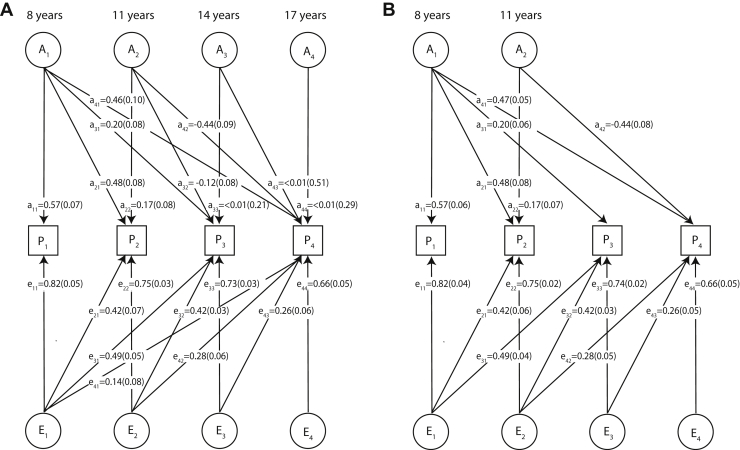
Path diagram of the full Cholesky decomposition model for Social and Communication Disorders Checklist scores (A) and its reduced form (B). The full Cholesky decomposition model (A) and its most parsimonious reduced form (B) are described in detail in Table 1 (model 1 and 5, respectively). Corresponding to the phenotypic measures P1 (8 years), P2 (11 years), P3 (14 years), and P4 (17 years), the latent genetic factors with factor loadings (a) are A1 (8 years), A2 (11 years), A3 (14 years), and A4 (17 years), and the latent residual factors with factor loadings (e) are E1 (8 years), E2 (11 years), E3 (14 years), and E4 (17 years). All path coefficients are standardized. There were 3295 participants with repeated scores across all ages. Note that the variance of latent variables is constrained to unit variance; this is omitted from the diagrams to improve clarity.